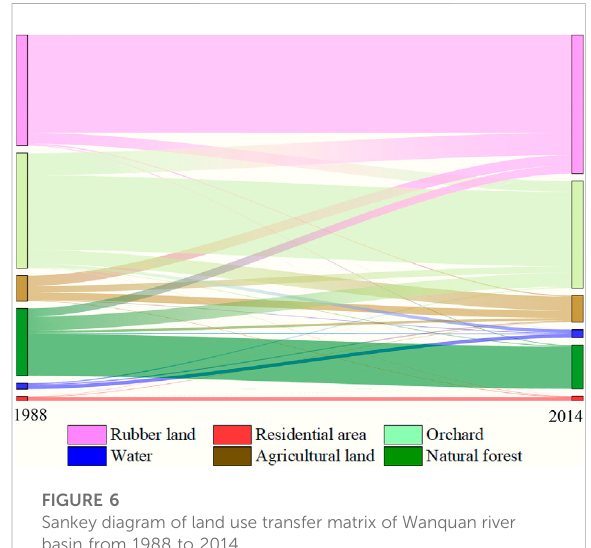
FIGURE 6 Sankey diagram of land use transfer matrix of Wanquan river basin from 1988 to